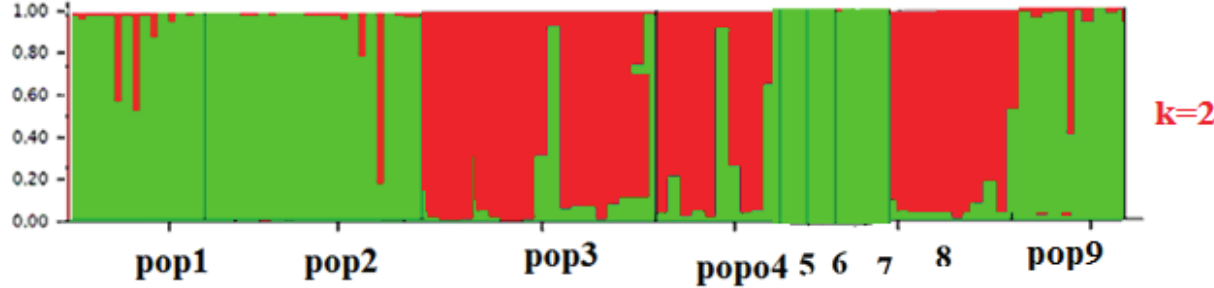
Figure 5. STRUCTURE plot of Ae. tauschii populations based on k = 2, Numbers are according to Table 1.